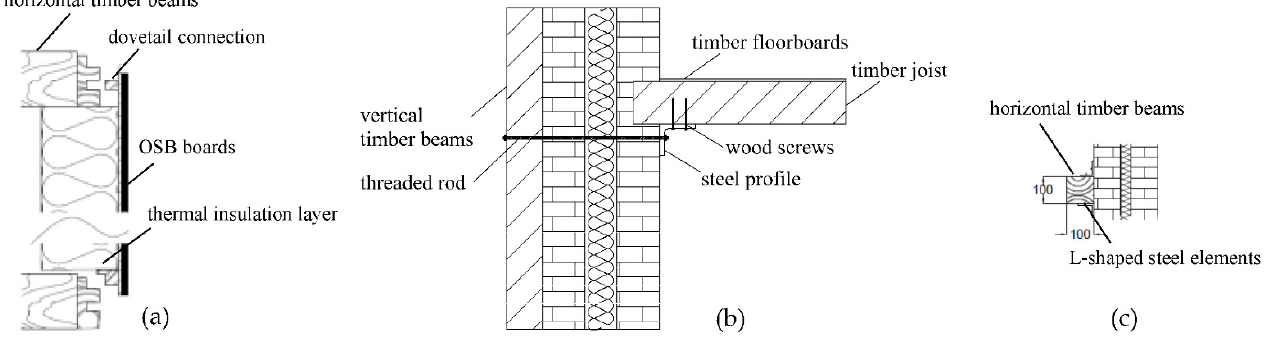
Figure 6. Design plans for the implementation of the presented seismic and energy retrofitting strategy: ( a ) Panel configuration ( b ) Connection with the floors ( c ) Connection with the facade wall (dimensions in mm).